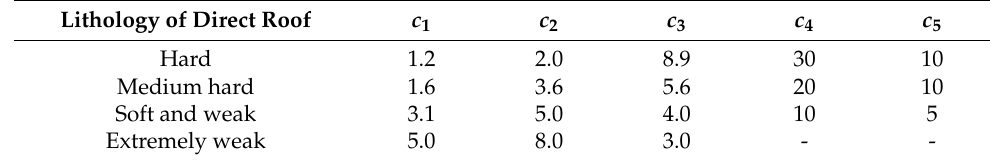
Table 1. Selection of coefficients in the equation for predicting DHWF.